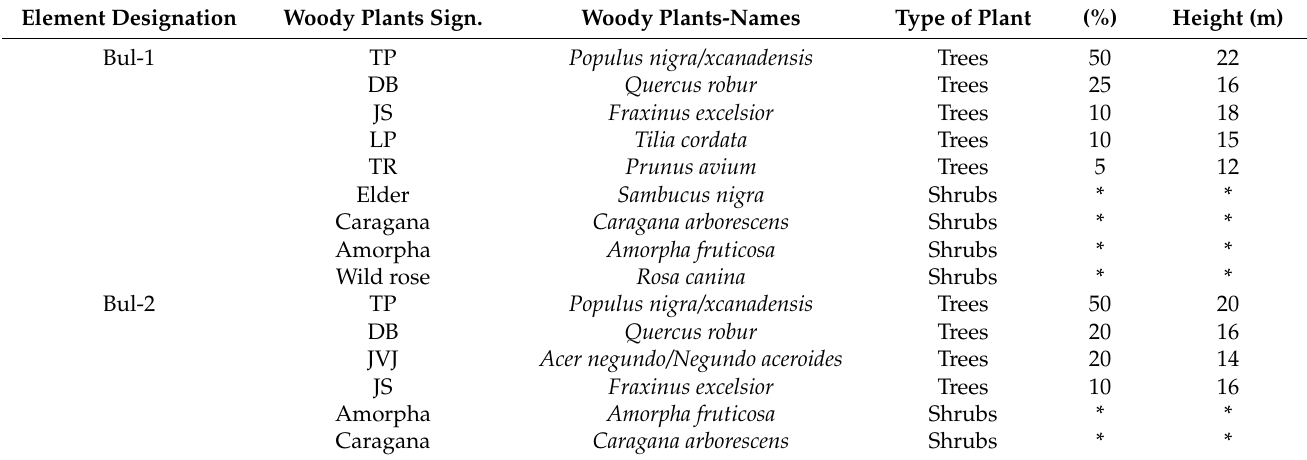
Table 10. Example of evaluation woody plant representation of two windbreaks in study locality Bulhary. Element